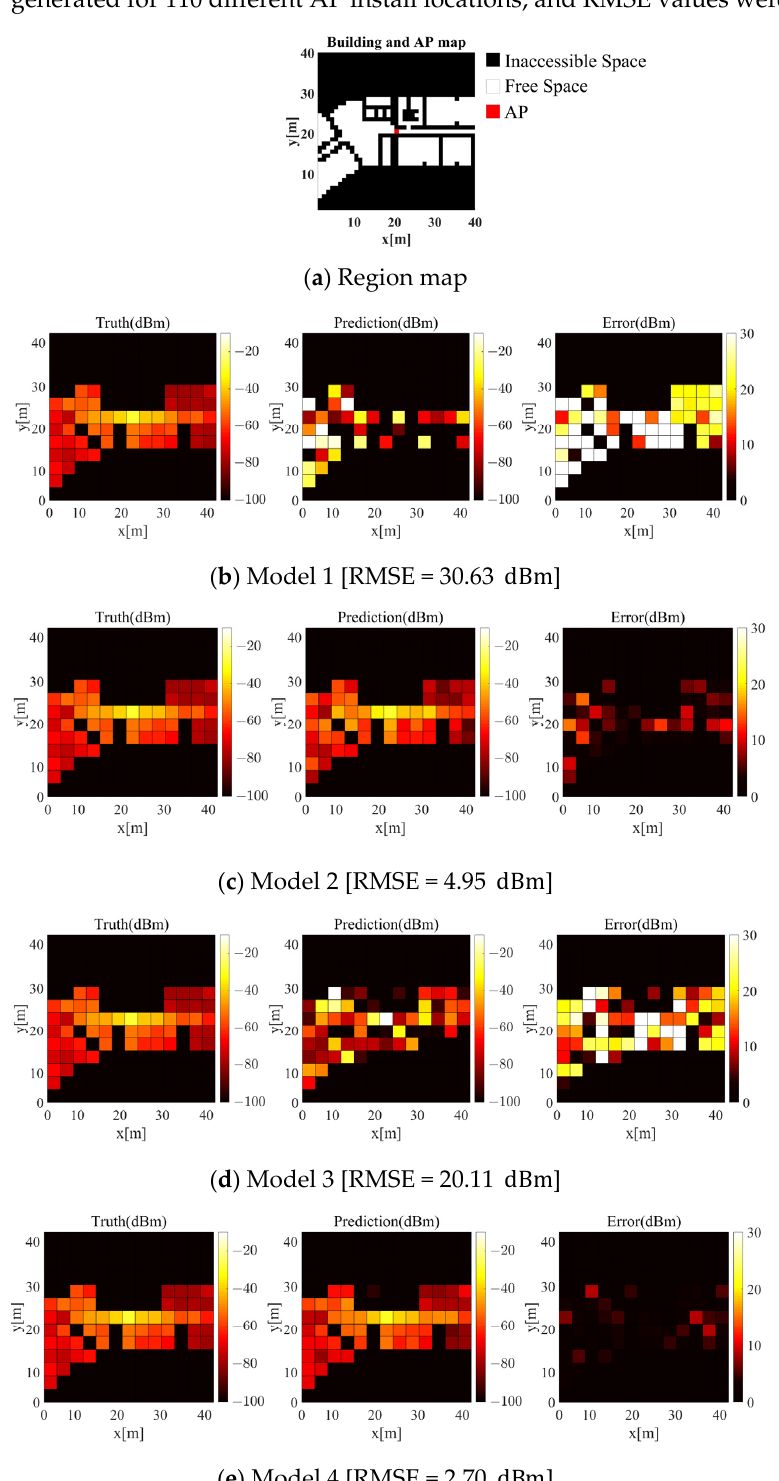
Figure 12. Model performance.